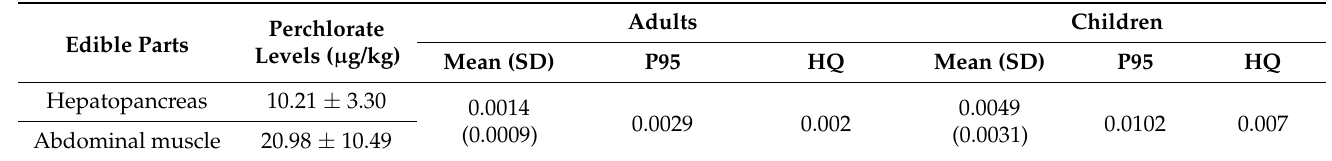
Table 2. Probabilistically estimated daily intake (EDI, µ g/kg bw/day) of perchlorate from